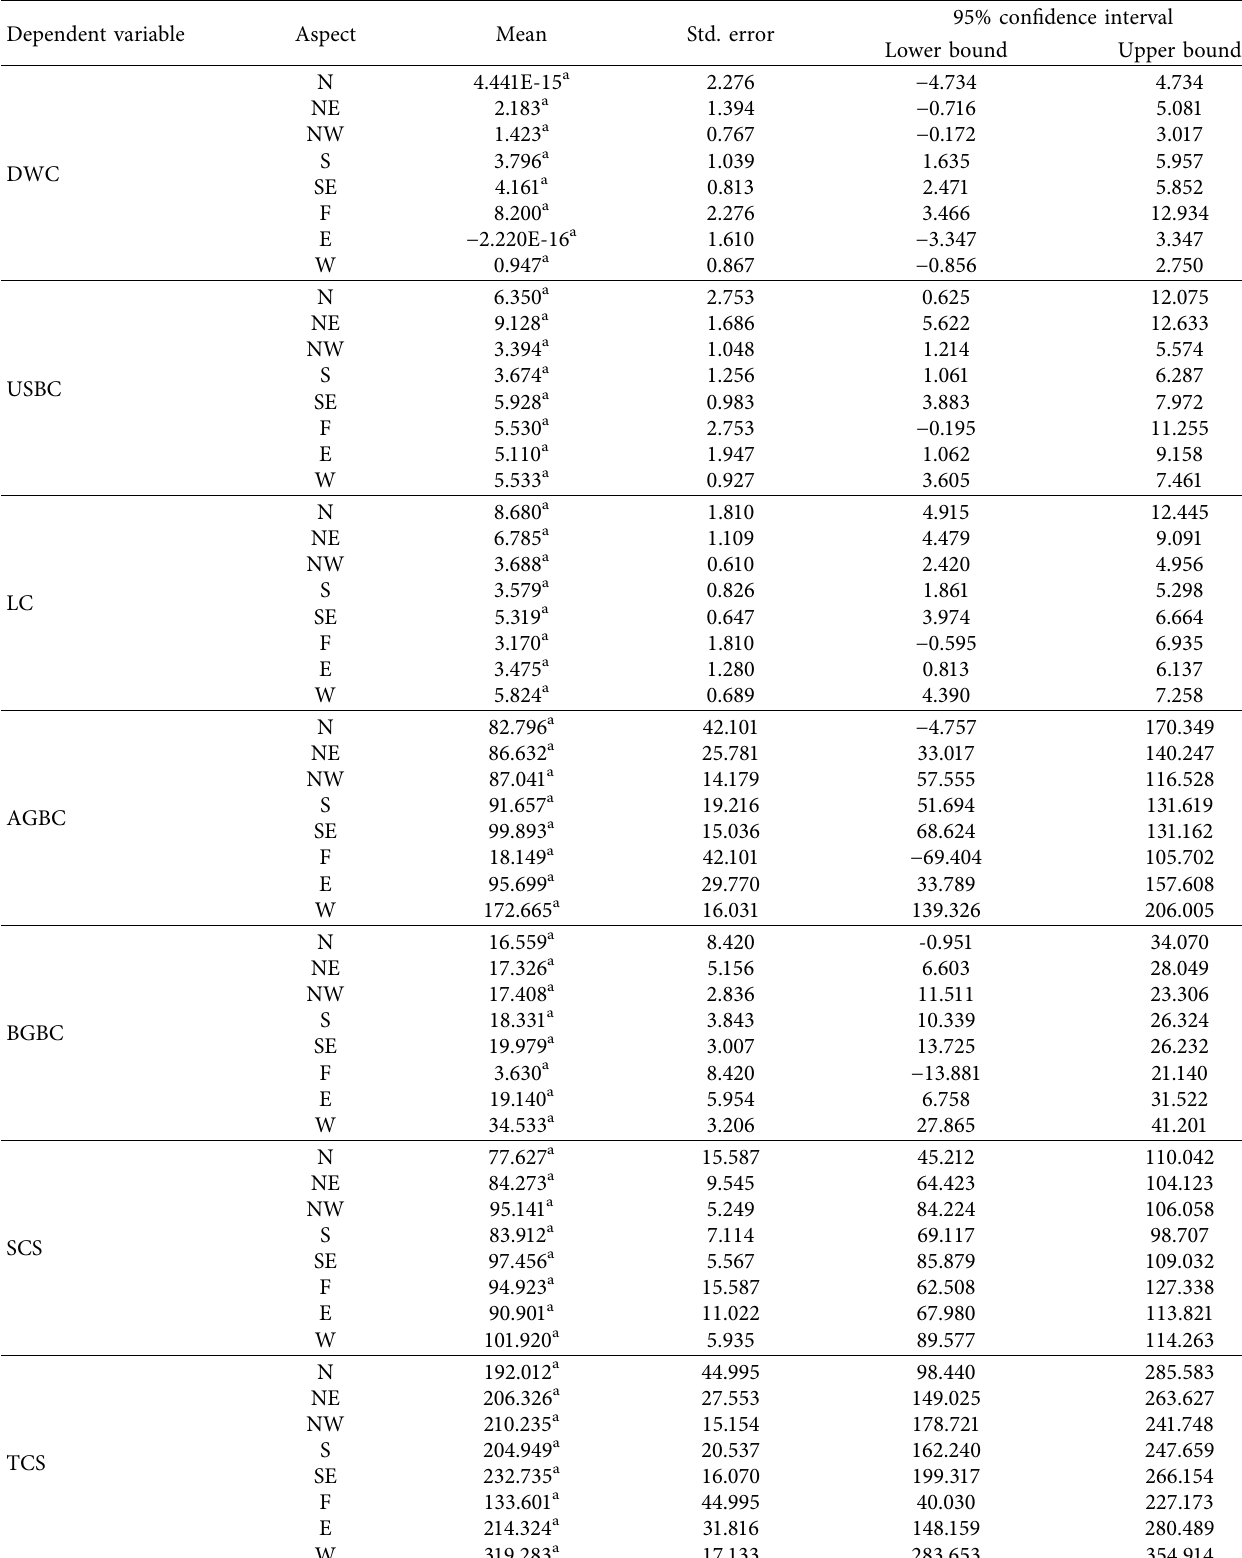
Table 14: Estimated marginal means of aspect in Ziba